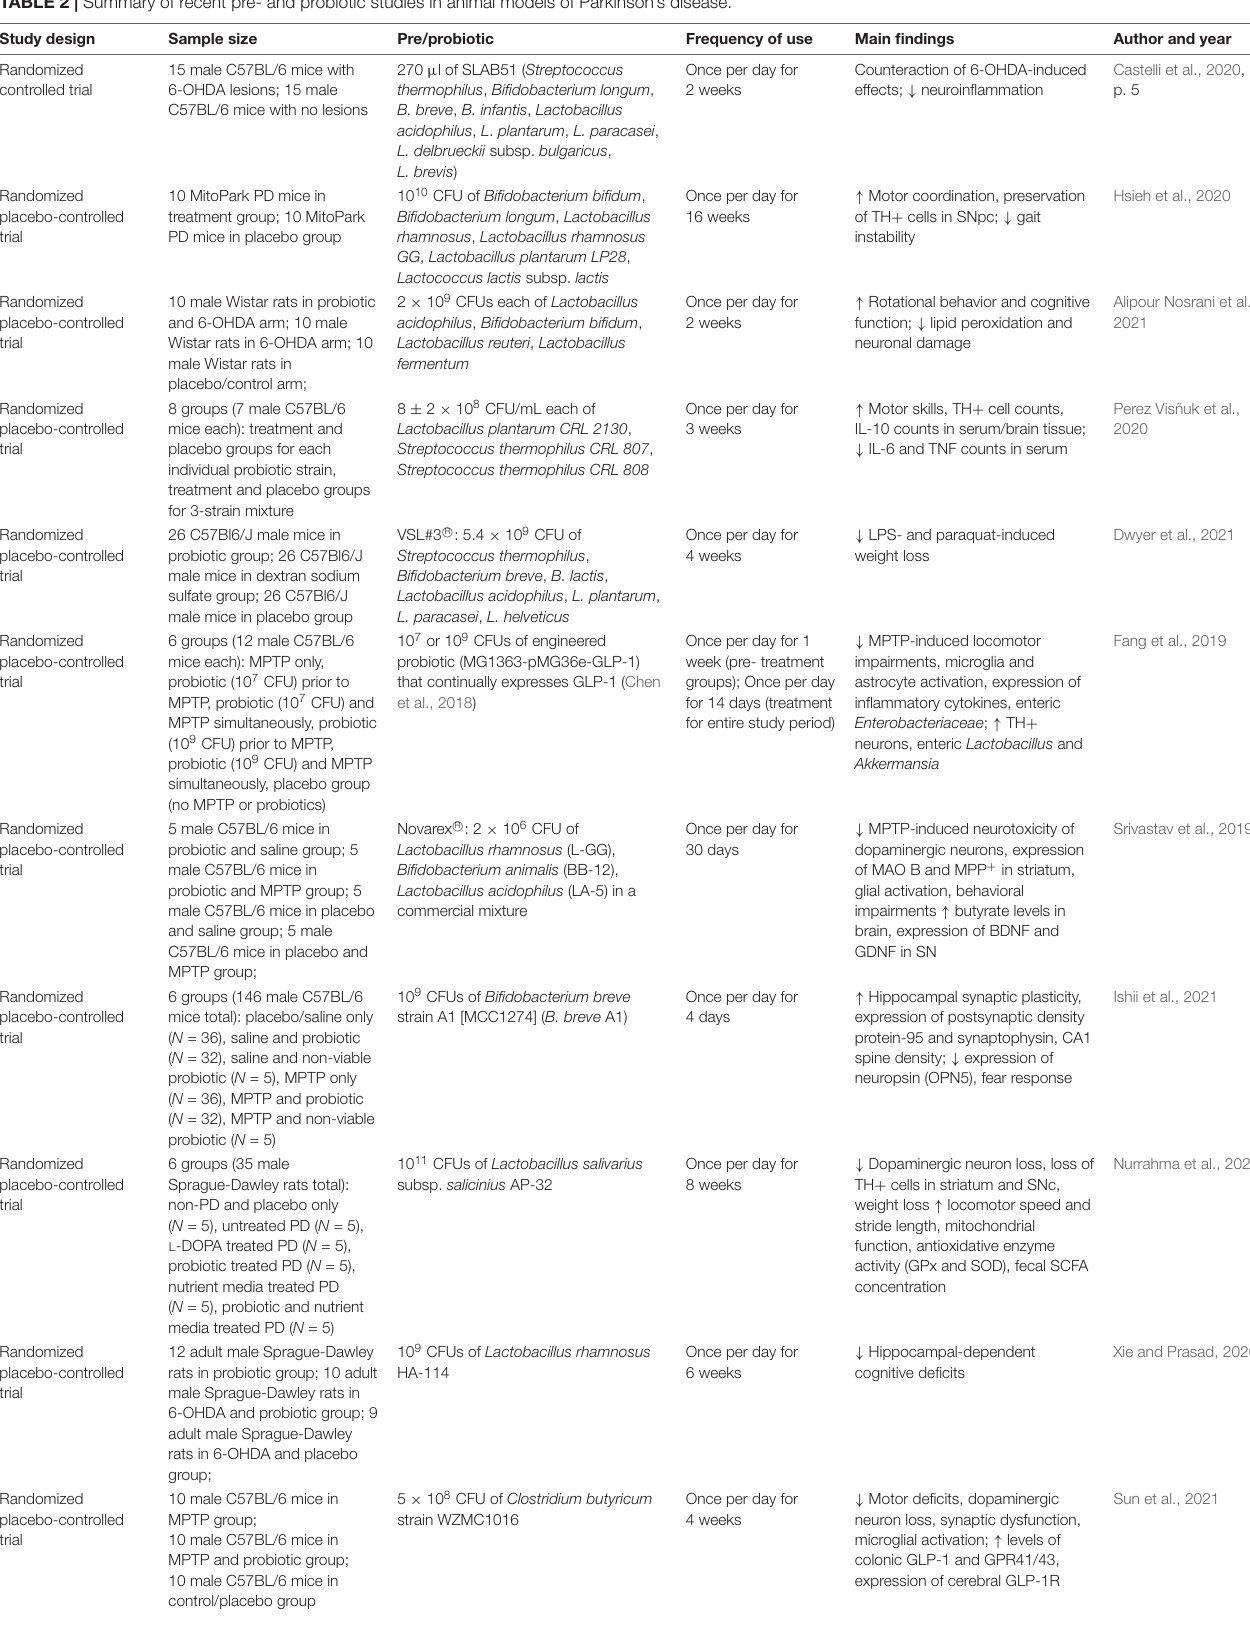
TABLE 2 | Summary of recent pre- and probiotic studies in animal models of Parkinson’s